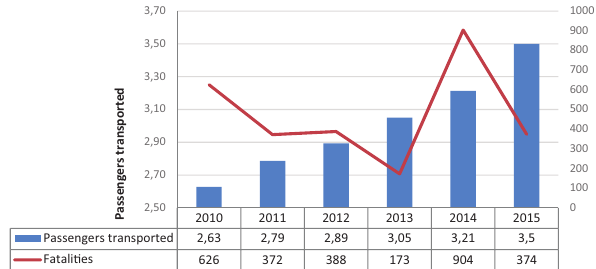
Figure 1. Number of fatal accidents and number of passengers 2010−2015 (source: created by the authors based on data of the World Bank, 2015 and ICAO,